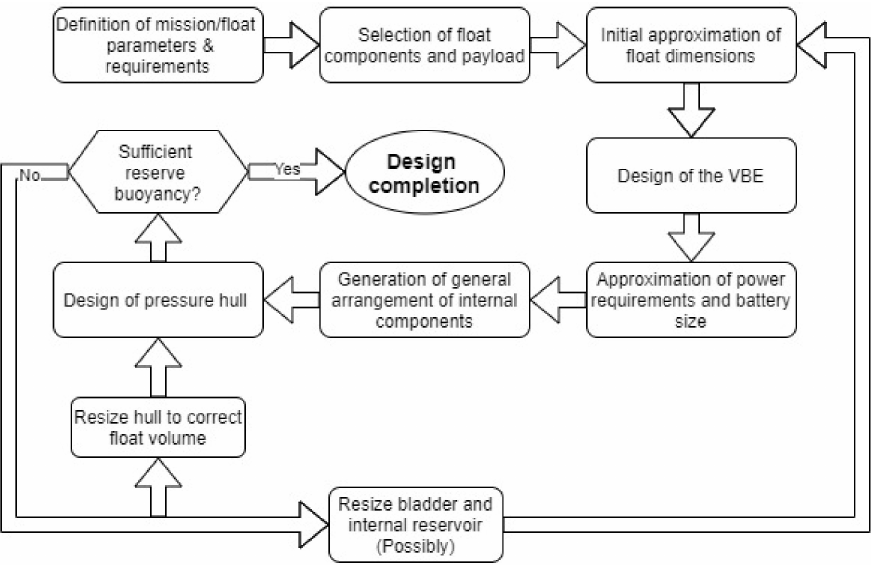
Figure 1. Float design